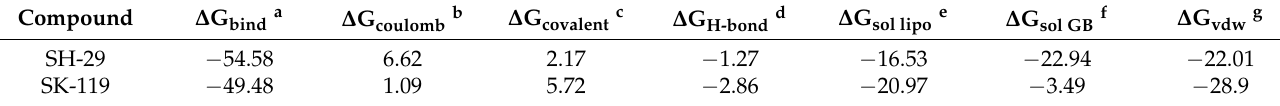
Figure 3. The total binding free energies of compound SH-29 (dark blue) and compound SK-119 (light blue) and the contribution of various interactions such as coulomb—coulomb energy, covalent—covalent binding energy, Hbond—H-bond energy, lipo—lipophilic energy, SolvGB—generalized born electrostatic solvation energy, vdw—Van der Waals energy. Table 1. Binding free energy results on SH-29 and